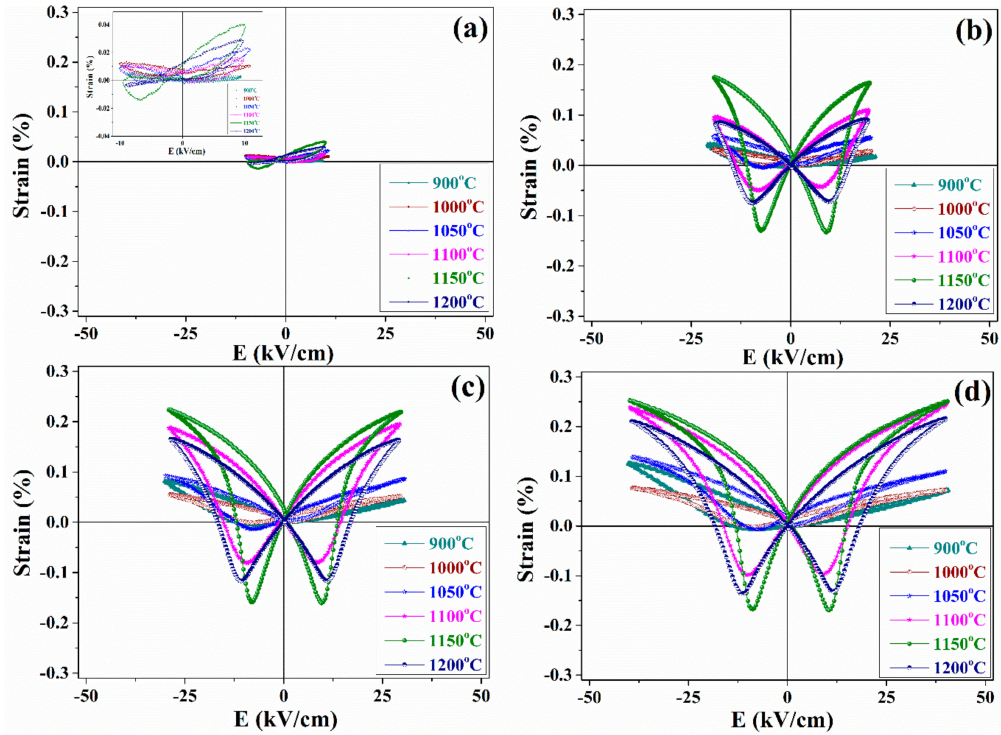
Figure 5. Bipolar strain vs. electric field ( S-E ) hysteresis curves measured at ( a ) 10 kV / cm, ( b ) 20 kV / cm, ( c ) 30 kV / cm and ( d ) 40 kV / cm, respectively, for the microwave-sintered PLZT 8 / 60 / 40 ceramics, 1